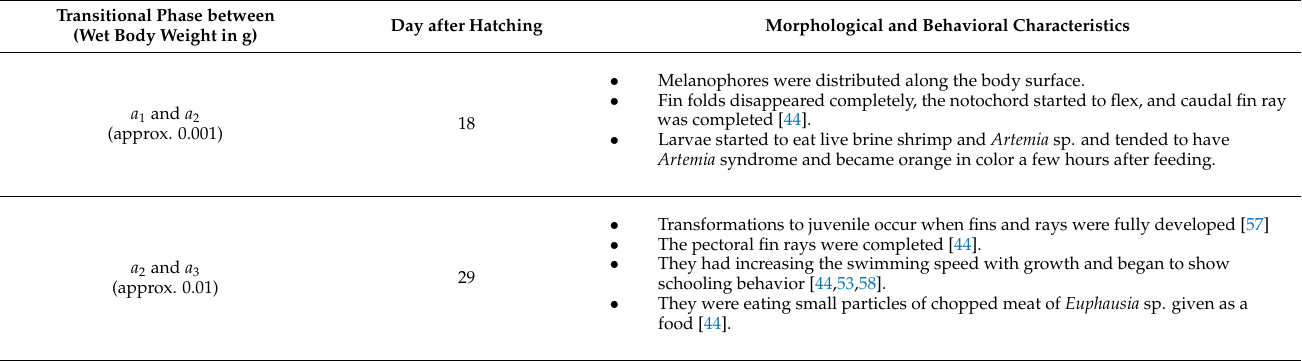
Table 4. Morphological and behavioral characterization of Japanese anchovy in different phases of